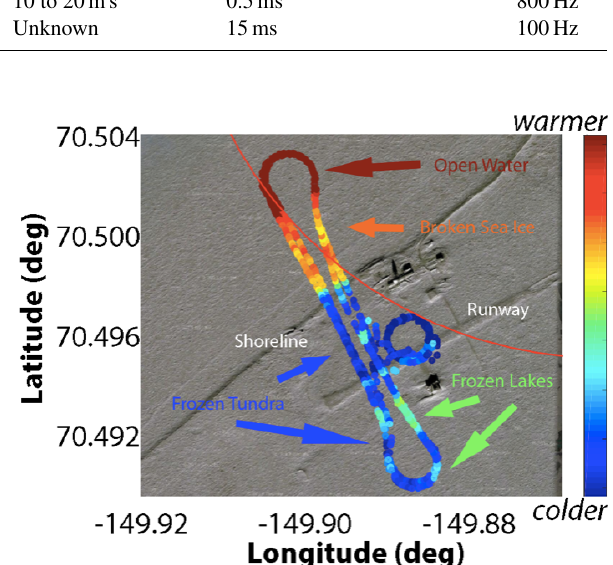
Figure 2. An example of data from the downward-looking IR sen- sor from a fall flight at Oliktok Point, Alaska, during freeze-up of the surface. The thermopile voltage plotted here is a proxy for the temperature of the target. The background image is © GoogleMaps, as downloaded using their API in